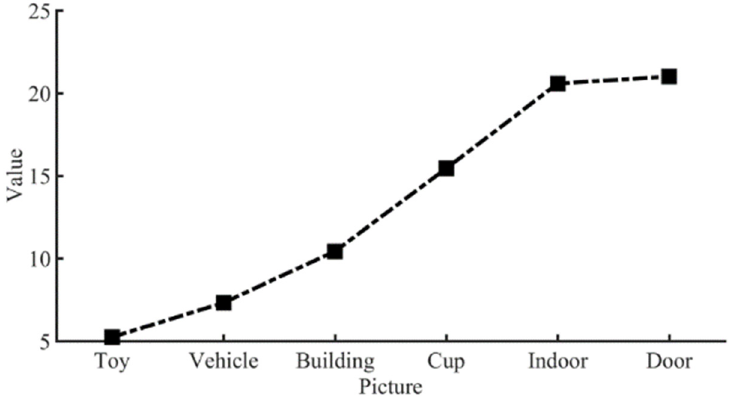
Figure 24. Evaluation values of real shooting images.